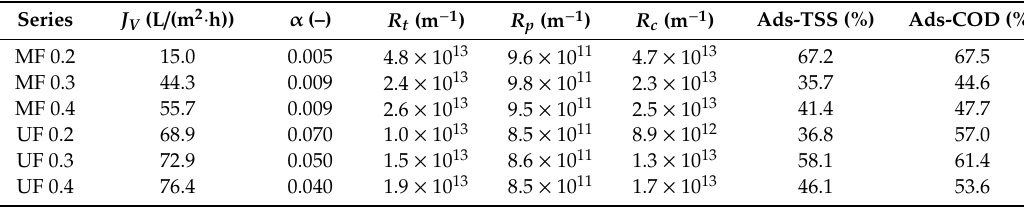
Table 2. Hydraulic e ff ects of membrane